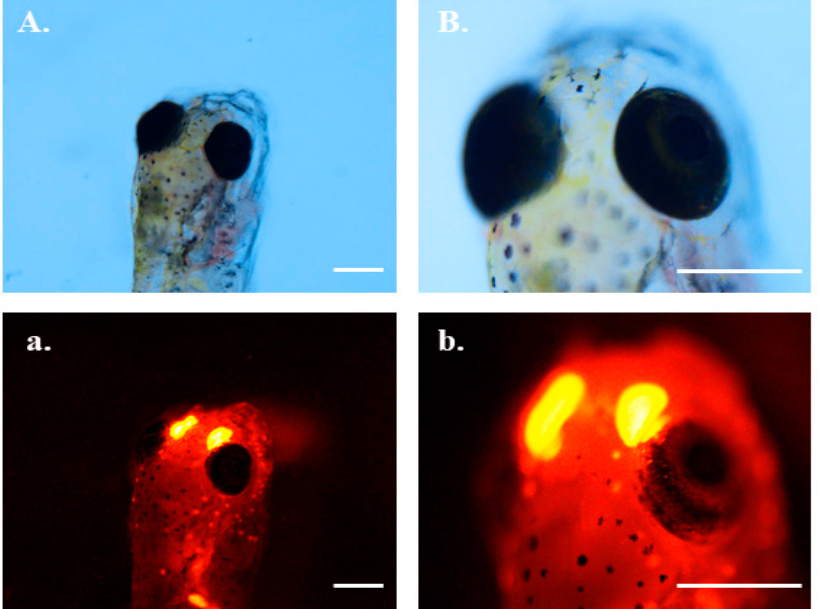
Figure 7. The larvae of grass carp after exposure to 1 µ m red fluorescent microplastics. Photographs were taken under a brightfield microscope (capital letters A , B ) and red fluorescent microscope (lowercase letters a , b ). B/b is a larger version of A/a . Scale bar = 0.5 mm.